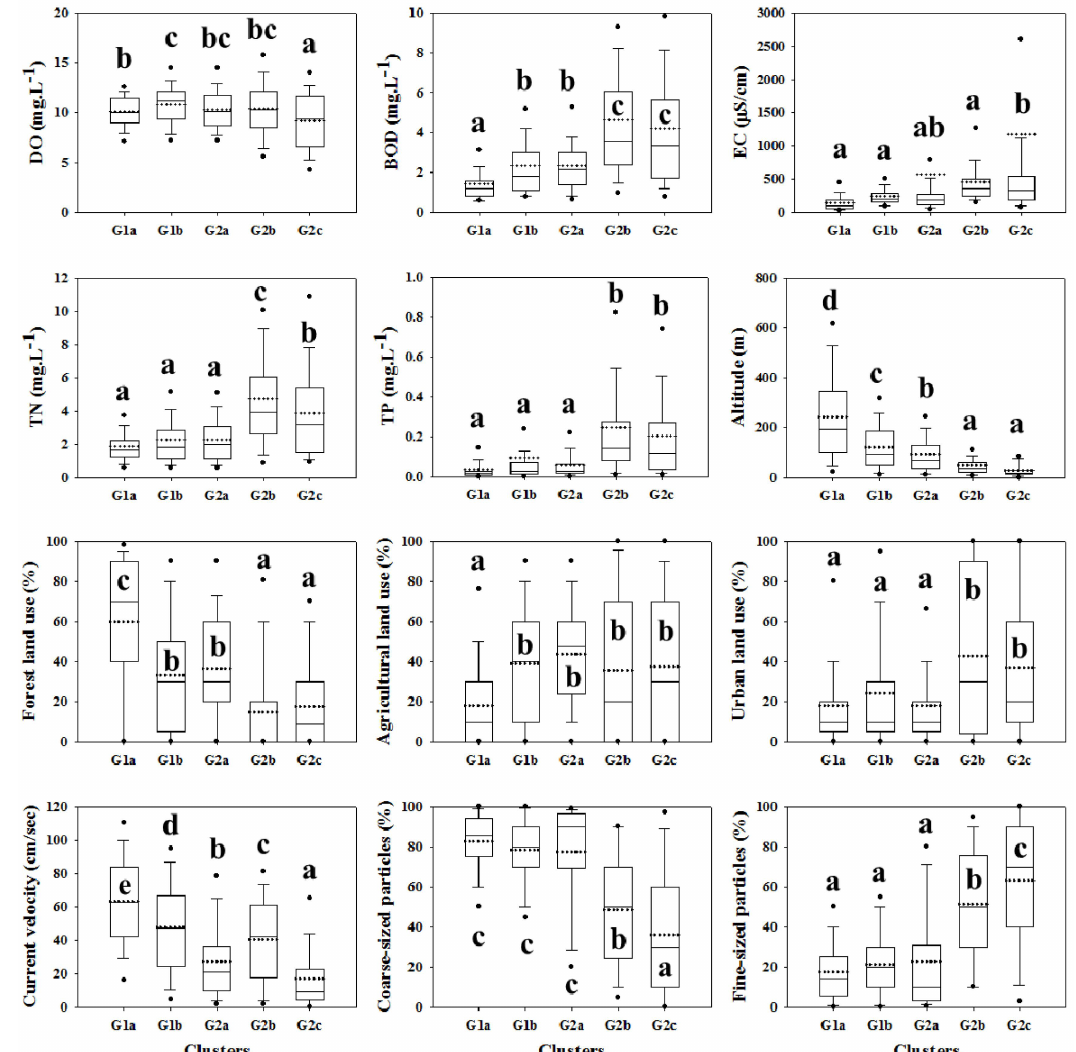
Figure 3. Distribution of selected environmental variables among the five clusters of the 720 sampling sites which were identified by cluster analysis with Sørenson distance measure. Box represents the 25th and 75th percentiles and whiskers indicate the 5th and 95th percentiles with standard deviations (error bar). The mean (horizontal dotted line) and median (horizontal solid line) are shown in each box. Different small letters indicate significant difference based on a Dunn’s multiple comparison test at p <